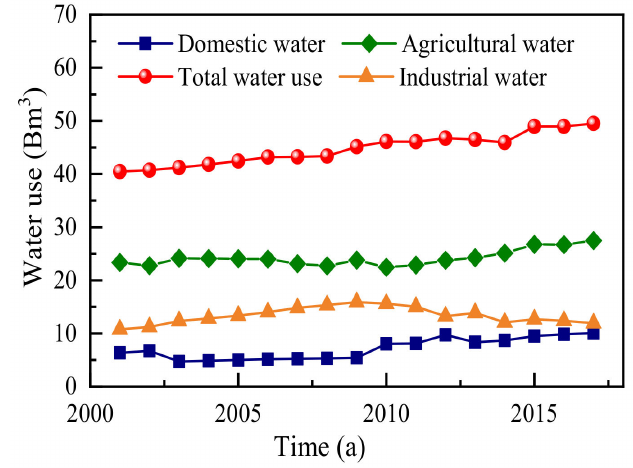
Figure 6. Change in basin water use.